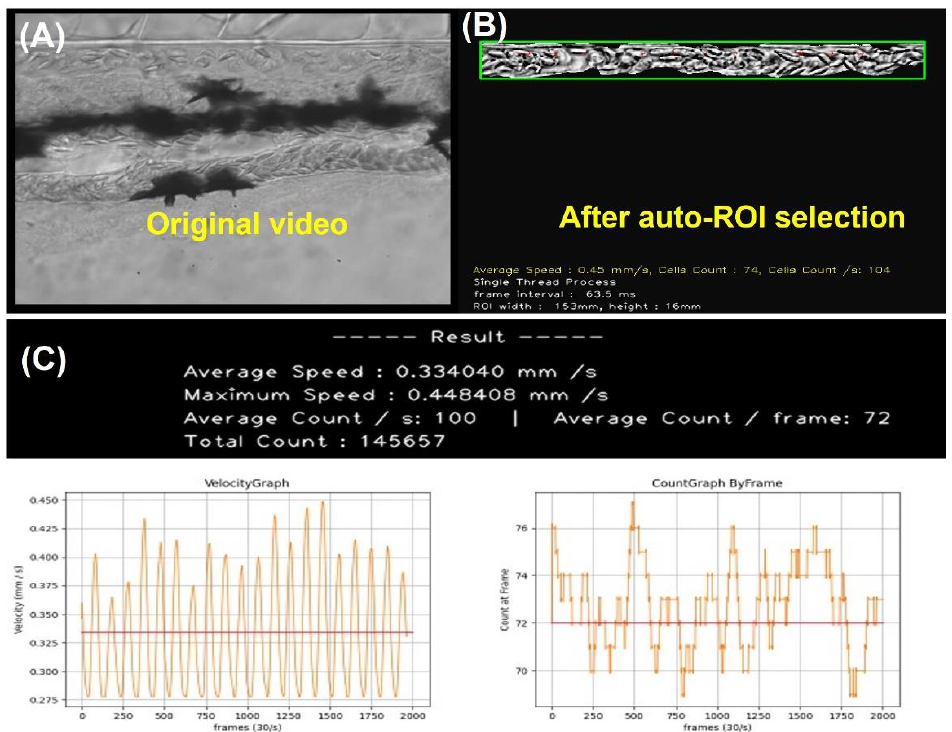
Figure 3. The computation of blood velocity and blood cell count in selected ROI and the displayed oscillation pattern over time in zebrafish aged 3 dpf. ( A ) ROI was chosen within the dorsal aorta for blood flow measurement. ( B ) Shaky video footage of blood vessels after performing video stabilization and the masked area presented for smooth oscillation. ( C ) The red line points to the average blood flow velocity (left panel) and blood cell count (right panel).